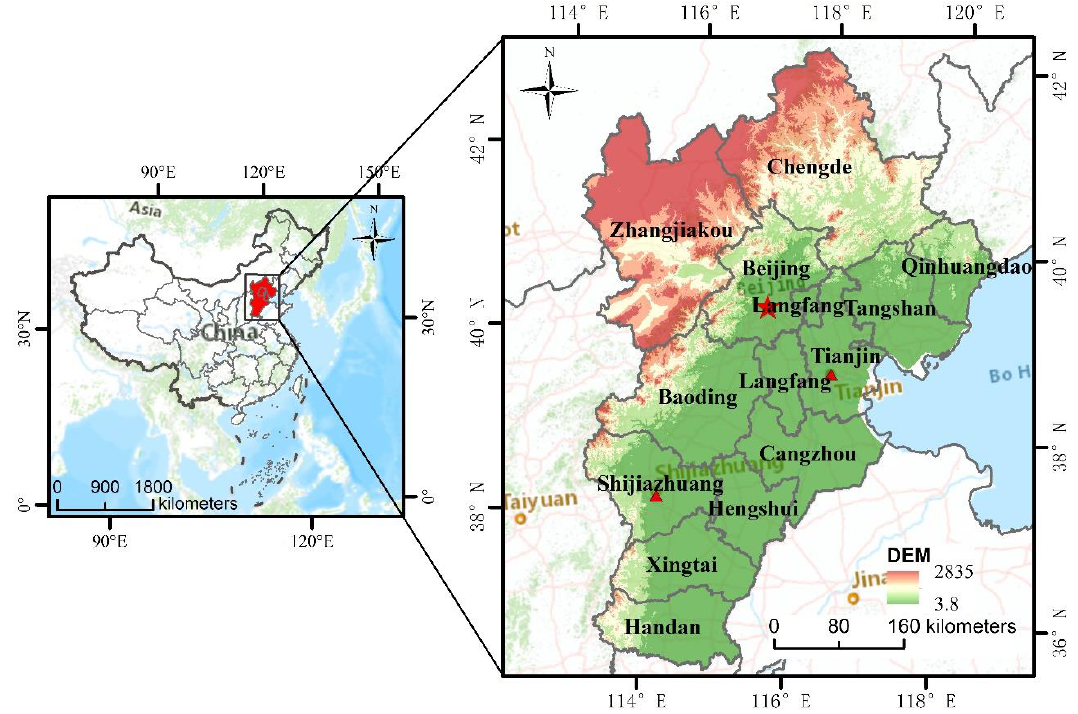
Figure 1. Geographical location of Beijing – Tianjin – Hebei. DMSP-OLS nighttime lighting data was obtained from the National Oceanic